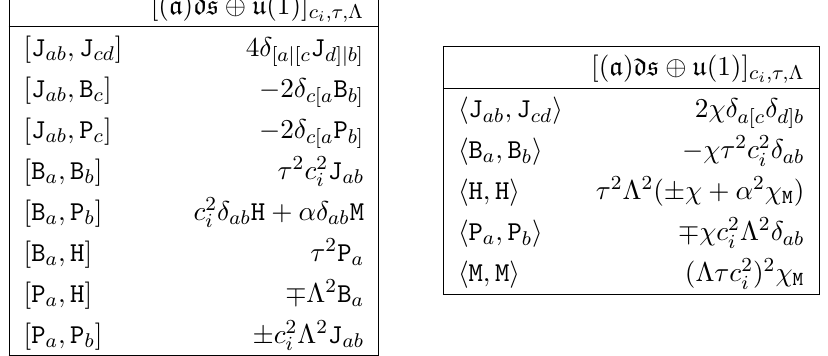
Table 4 . Commutation relations and invariant metric for the trivially centrally extended ads (upper sign) and ds (lower sign) algebras in dimension D + 1.